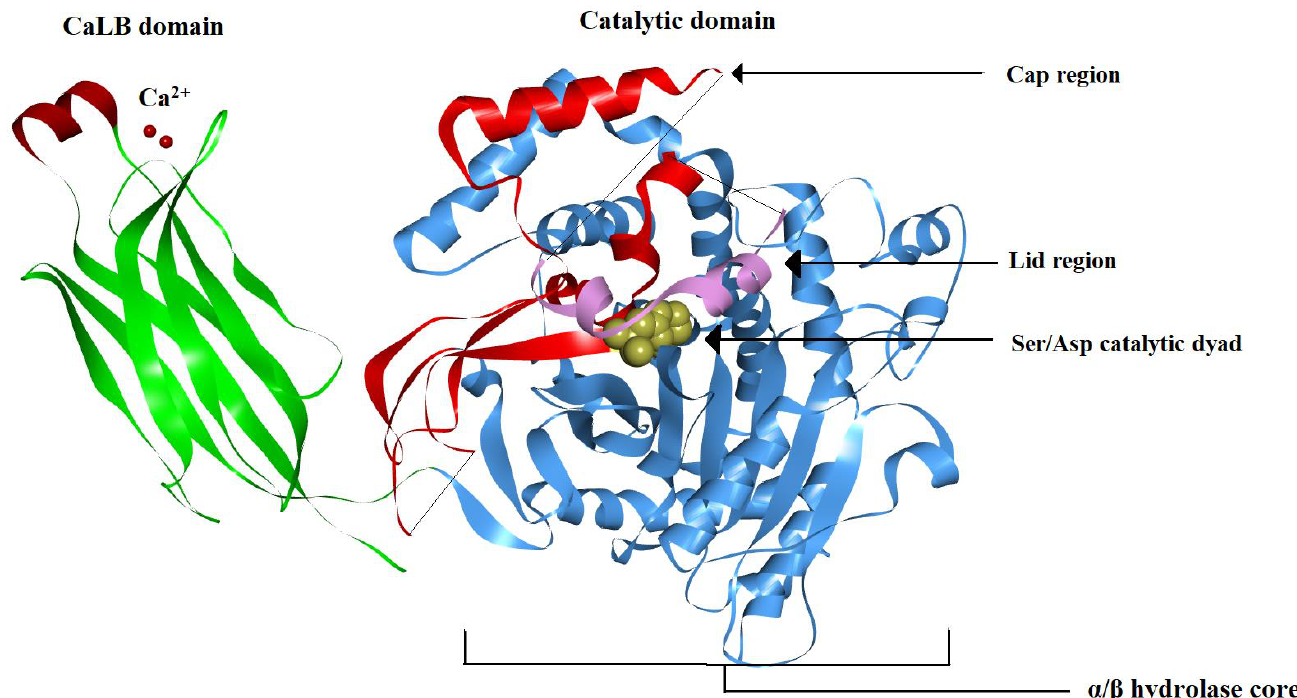
Figure 11. Ribbon diagram of a typical cPLA2 (PDB: 1CJY). The Ca 2+ -dependent lipid-binding (CaLB) domain is shown in green on the left side of the figure, with the two bound Ca 2+ ions (required for protein translocation to the membrane) shown as red spheres. The catalytic domain is shown on the right side, the α / β hydrolase core is shown in blue and the catalytic dyad Ser/Asp is shown in yellow. The enzyme cap is shown in red, and the lid region covering the active site funnel is colored pink. The lid region prevents the lipid substrates to come in contact with the active site [31]. (Image generated using BIOVIA Discovery